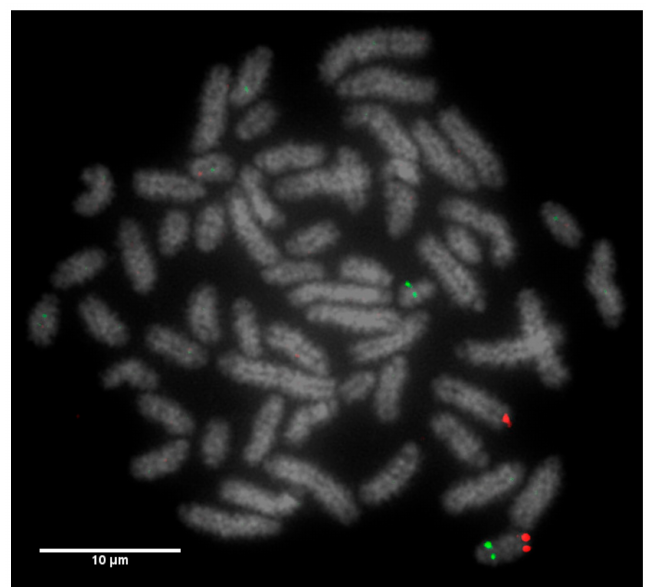
Figure 5. Labelled FISH probes for chromosome 23, where the proximal probe is CH240-102P19 (FITC) and the distal probe is (CH240-374G6 (Texas Red). A misplacement of signals illustrates a reciprocal translocation between chromosome 12 and chromosome